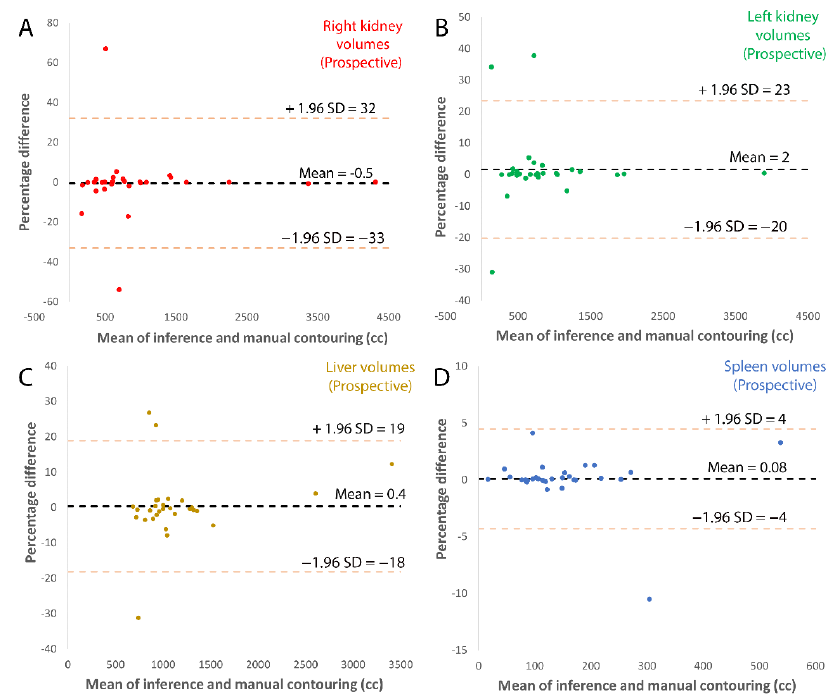
Figure 5. Bland-Altman plots of prospective validation comparing the inference volume with radiologist corrected volume for ( A ) left kidney, ( B ) right kidney, ( C ) spleen and ( D ) liver.